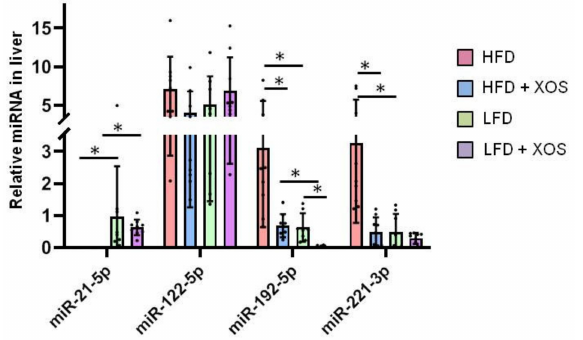
Figure 2. The relative expression levels of miRNAs in liver. n = 8–10/group. The graph shows the quantification of the miRNAs by real-time quantitative PCR. The black dots in the bars show individual data points. * indicates statistically significant ( p < 0.05) difference between the groups as determined by Mann Whitney U